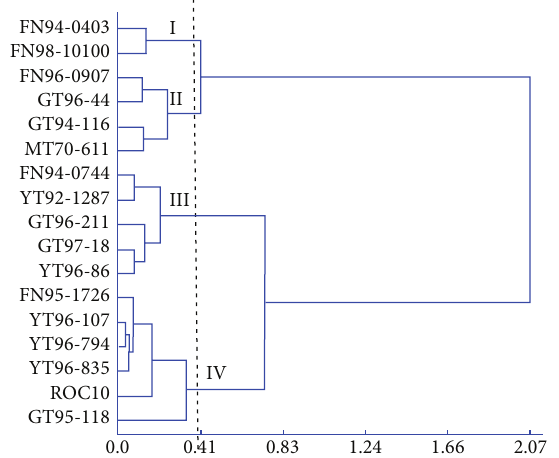
Figure 2: A clustering dendrogram based on canopy parameters of 17 sugarcane varieties.